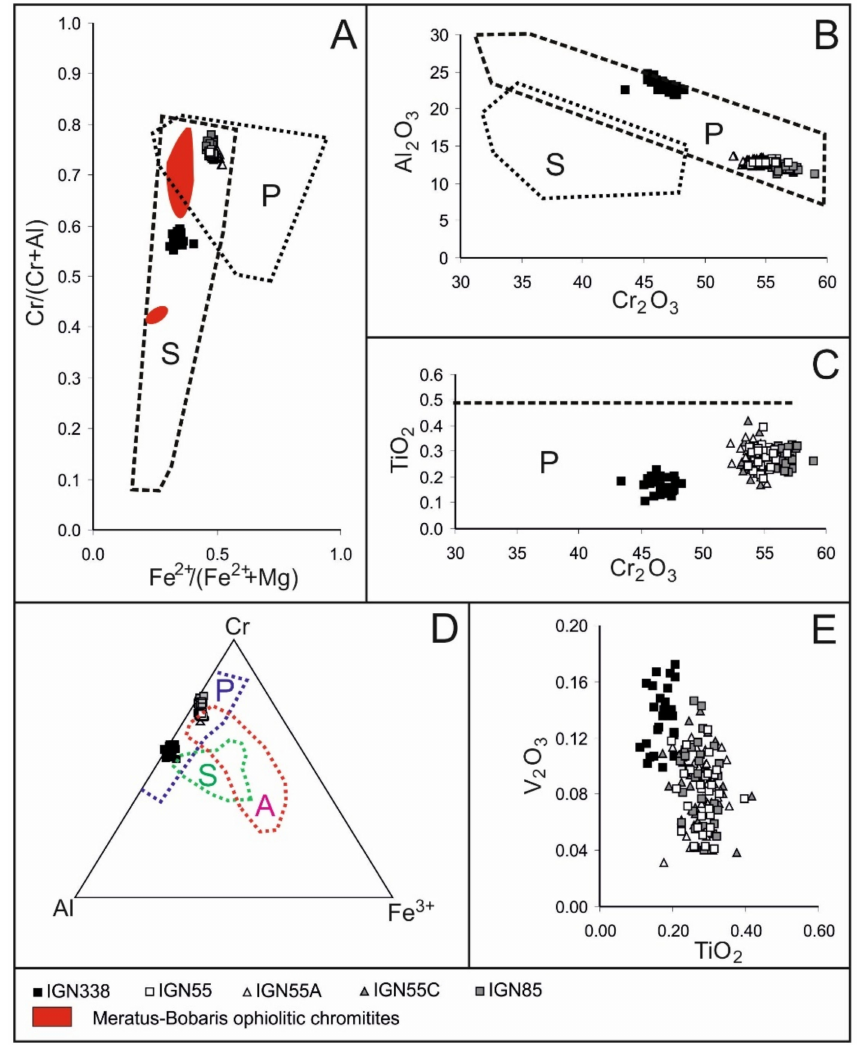
Figure 5. Composition of unaltered chromite from the Sebuku chromitites showing the co-existence of high-Al and high-Cr chromitites: ( A ) variation of the chromium number, Cr# = Cr/(Cr + Al) and bivalent iron number, Fe 2+ # = Fe 2+ /(Fe 2+ + Mg) and comparison with the chromitites from the Meratus–Bobaris ophiolite [36], ( B ) correlation between Al 2 O 3 and Cr 2 O 3 , ( C ) variation of Cr 2 O 3 and TiO 2 , ( D ) Cr–Al–Fe 3+ atomic ratios and ( E ) correlation of TiO 2 versus V 2 O 3 . p —field of